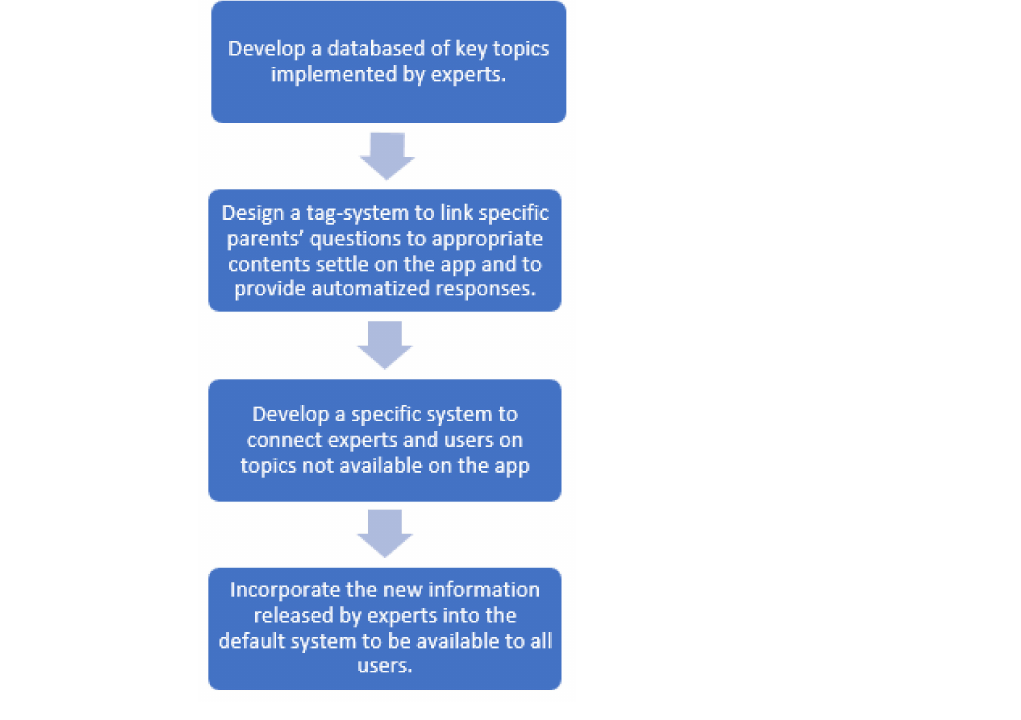
Figure 4. Development process of Nutripedia app. In Figure 5 the user flow is represented.